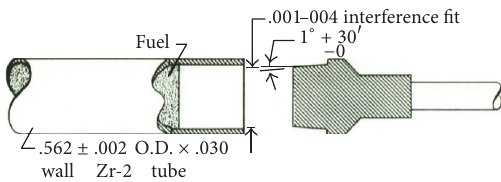
Figure 5: Weld joint designs for fusion welding (GTAW and LBW) [5].